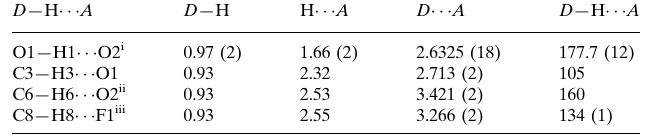
structure: SHELXL97 (Sheldrick, 2008); molecular graphics: ORTEP-3 for Windows (Farrugia, 1997) and PLATON (Spek, 2003); software used to prepare material for publication: WinGX (Farrugia, 1999) and PLATON